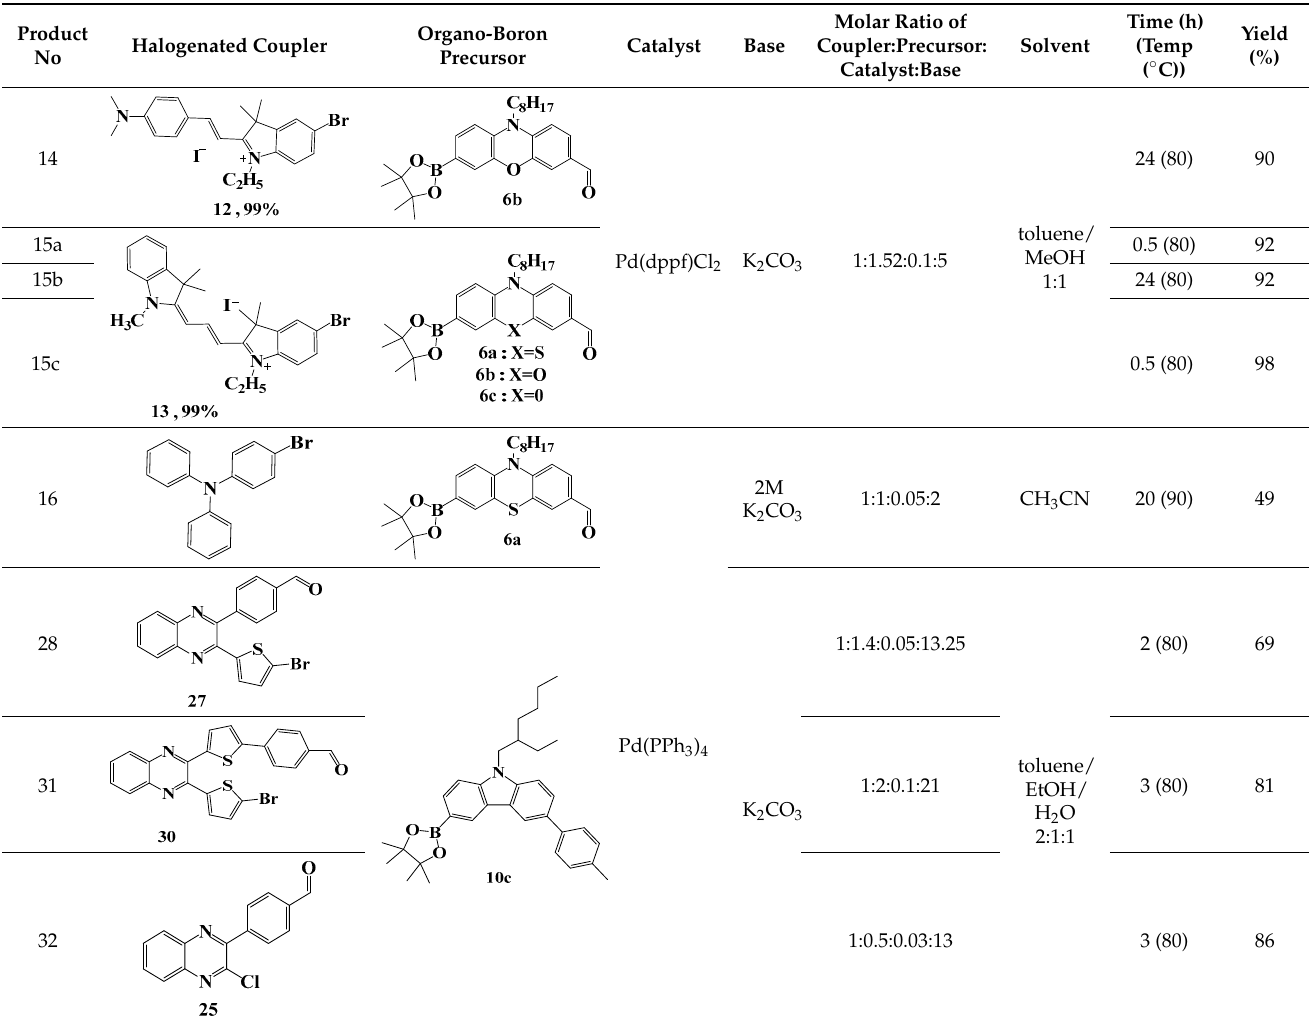
Table 4. Summary of Suzuki cross-coupling reactions of borylated N -alkyl PTZ, POZ, and Cz precursors with halogenated indolinium, TPA, and QX couplers.